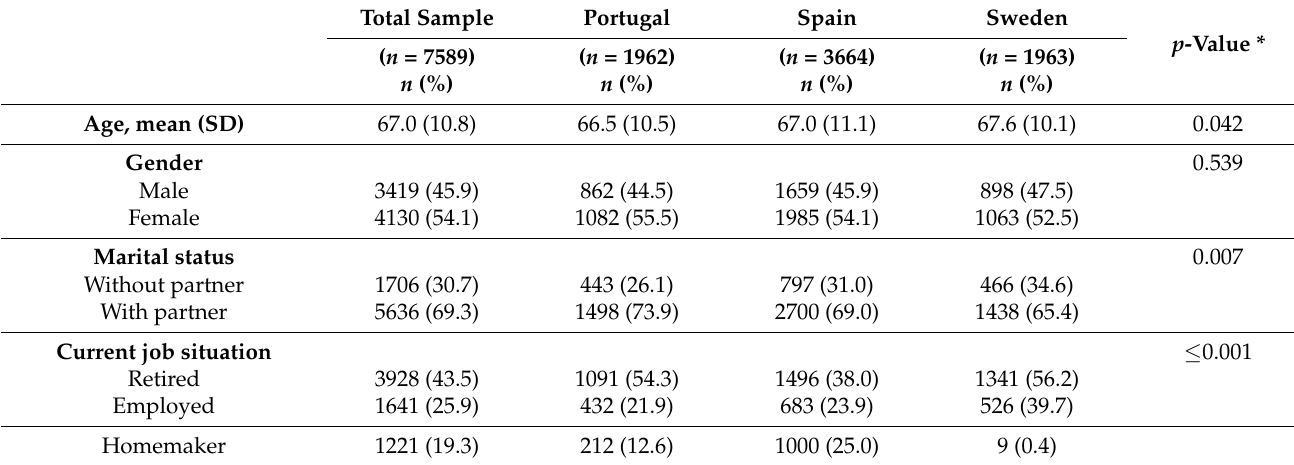
Table 2. Descriptive statistics of the study variables and differences by country in W4, complete cases (unweighted n, weighted